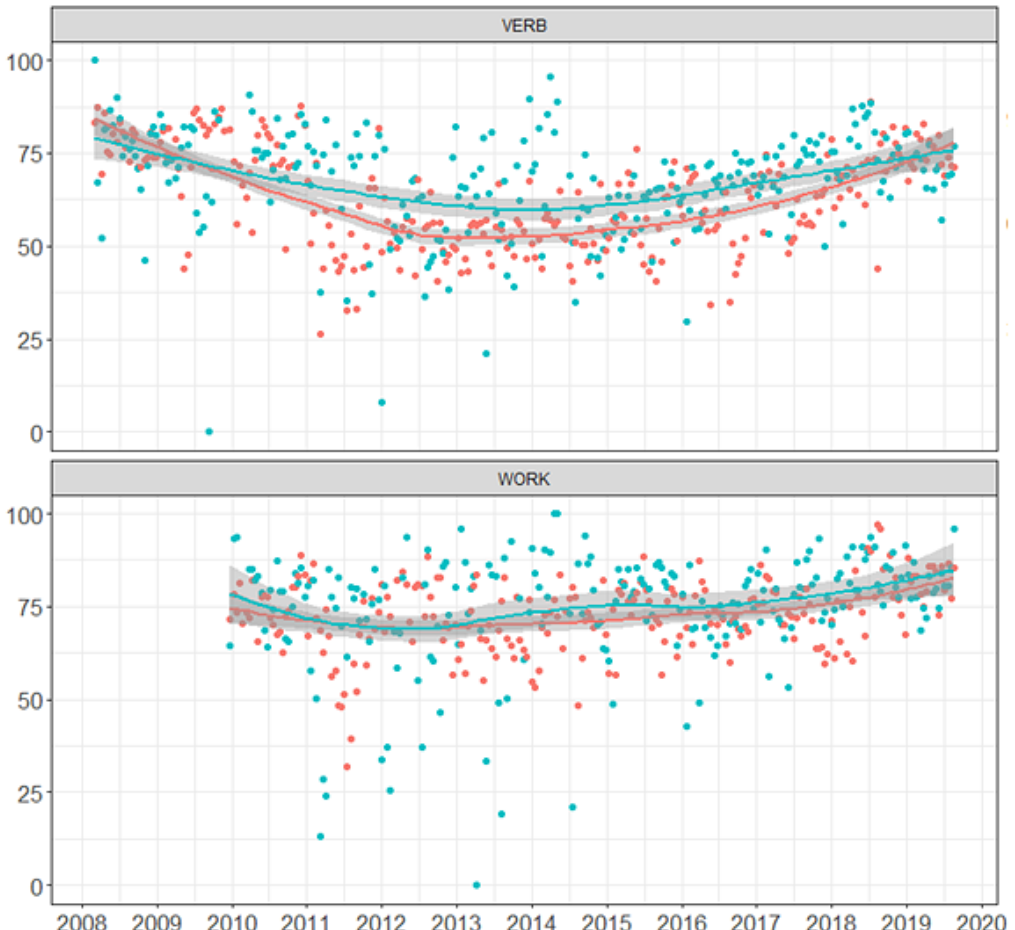
Figure 3. Mean values of the results in task executions summarized weekly, cluster 1 (blue) and cluster 2 (red). VERB: verbal memory; WORK: working